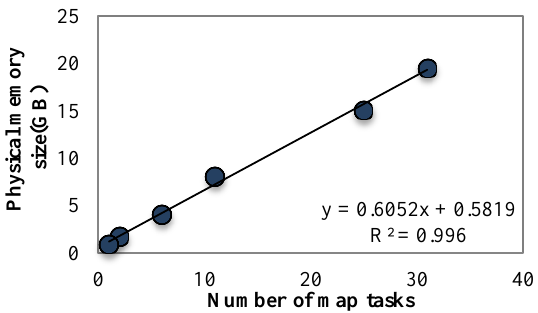
Figure 9. Number of Map tasks versus physical memory size (GB).